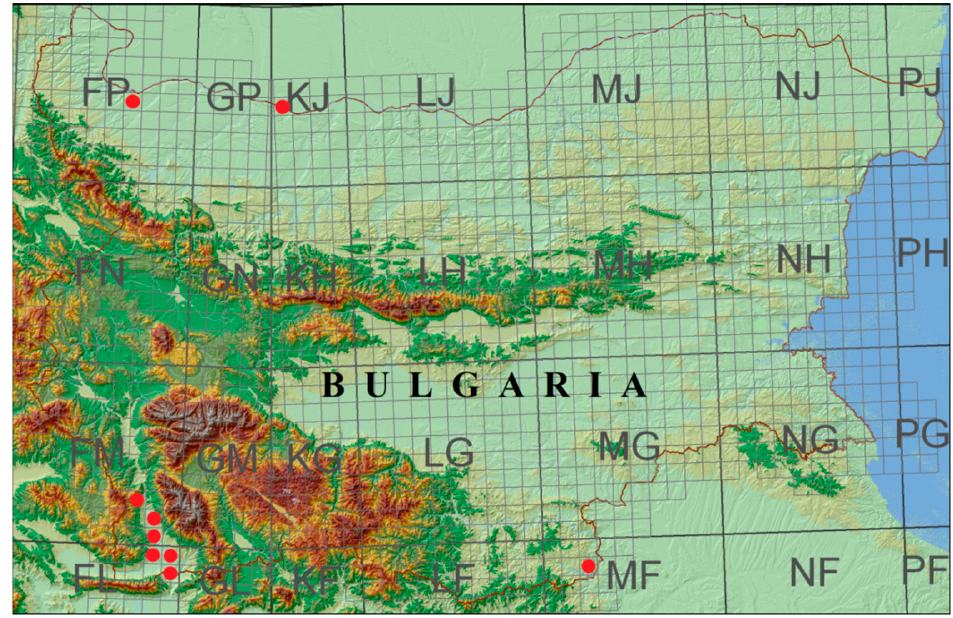
Figure 4. Map of the studied localities of A. tinctoria. ● /red circle/: the established localities. Table 6. List of the studied localities of A. tinctoria in Bulgaria.